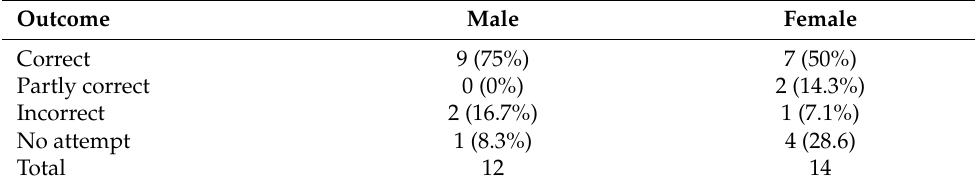
Table 2. Overall performances of students with different genders in the first word problem. Outcome Male Female Correct